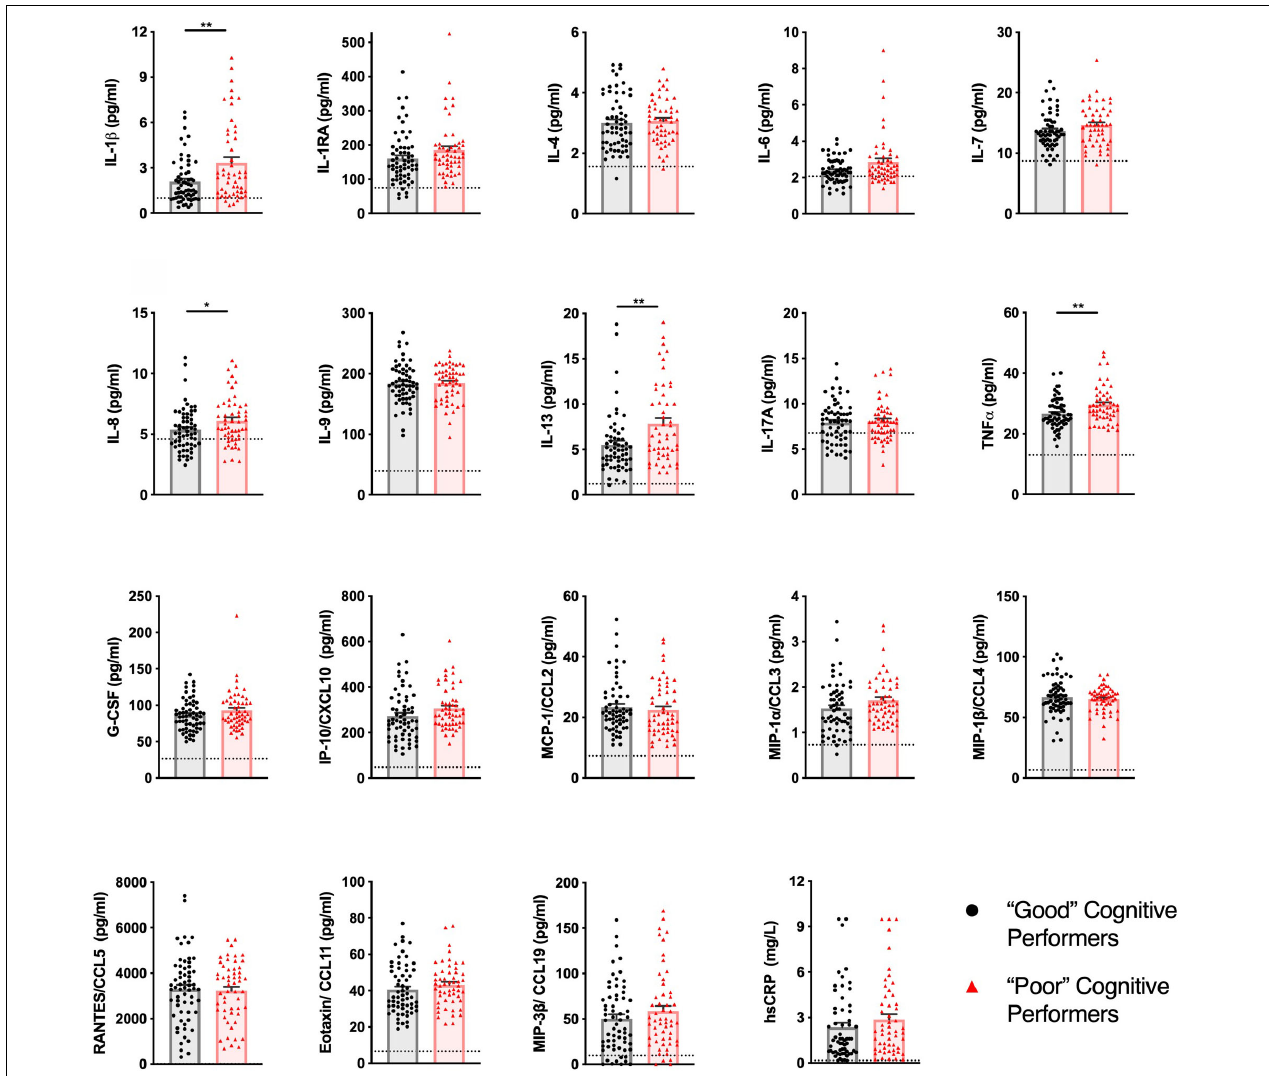
FIGURE 1 | Healthy senior individuals with distinct cognitive performances present differences in the concentration of peripheral immune molecules. The profile of cytokines, chemokines, and other immune molecules in the plasma of “Good” (black circles) and “Poor” (red triangles) cognitive performers. Dashed lines represent LLOQ (lower limit of quantification), and values below LLOQ were extrapolated from the standard curve. Dots represent each participant, columns represent the mean of the group, and bars the standard error of the mean (* p < 0.05, ** p < 0.01). in Supplementary Table 2 ). No differences were observed in the other analytes measured ( Supplementary Table 2